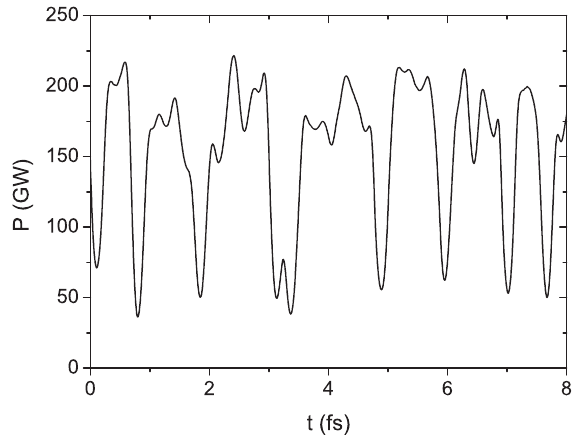
FIG. 7. Peak power of circularly polarized radiation at the exit of the afterburner (position 65 m on Fig. 6). A central part of the x-ray pulse is